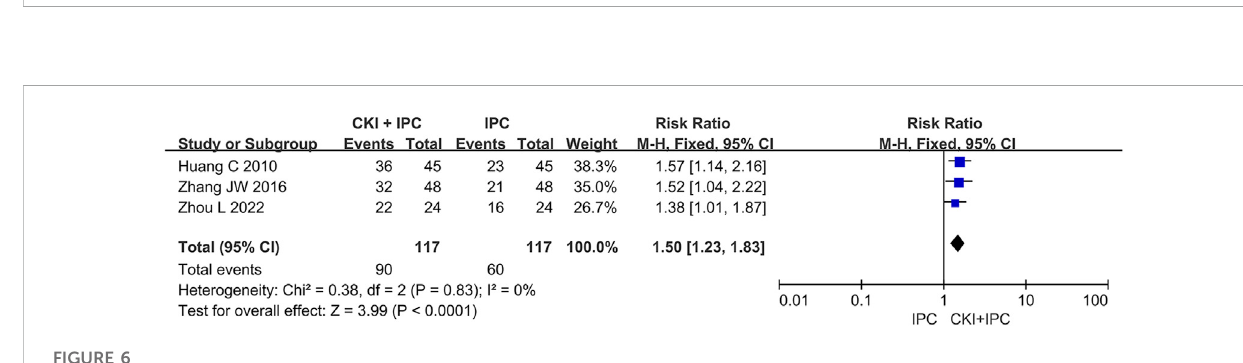
FIGURE 6 Forest plot and pooled risk ratios for the association of QoL (continuous data) with CKI + IPC and